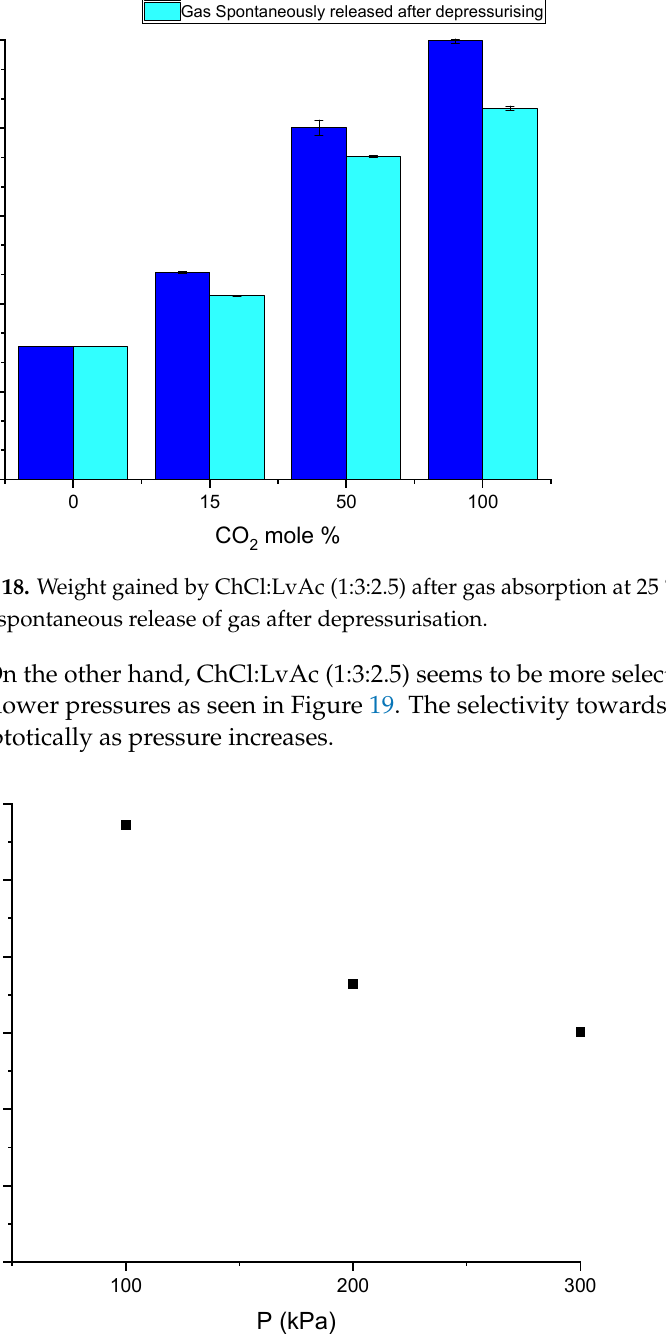
Figure 17. Absorption capacity of ChCl:LvAc (1:3:2.5) for different gas mixtures of CO 2 and N 2 . Experiments carried out at 25 °C and 250 rpm.